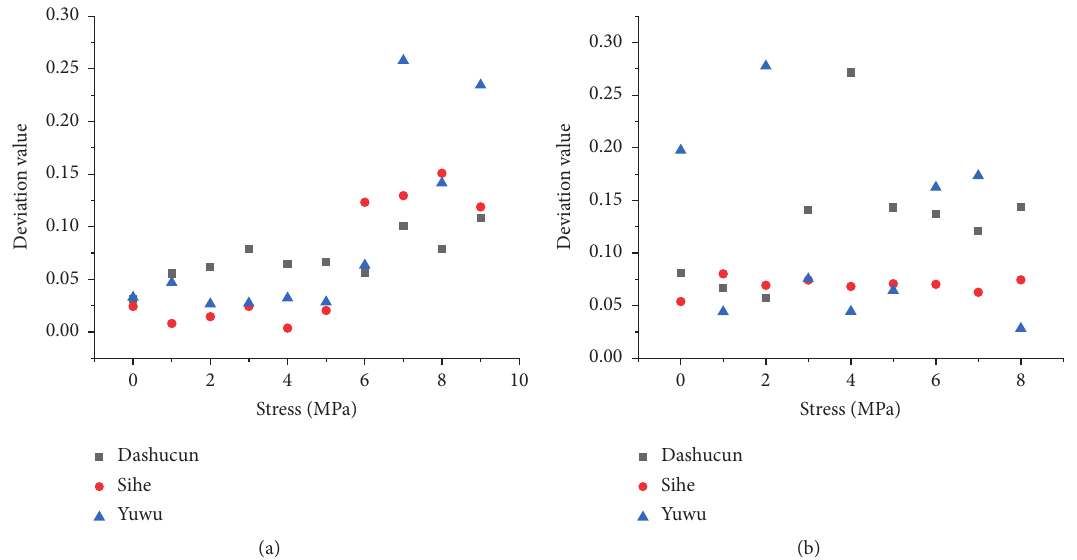
Figure 8: λ deviation degree under different loading paths. (a) Axial pressure. (b) Confining pressure.